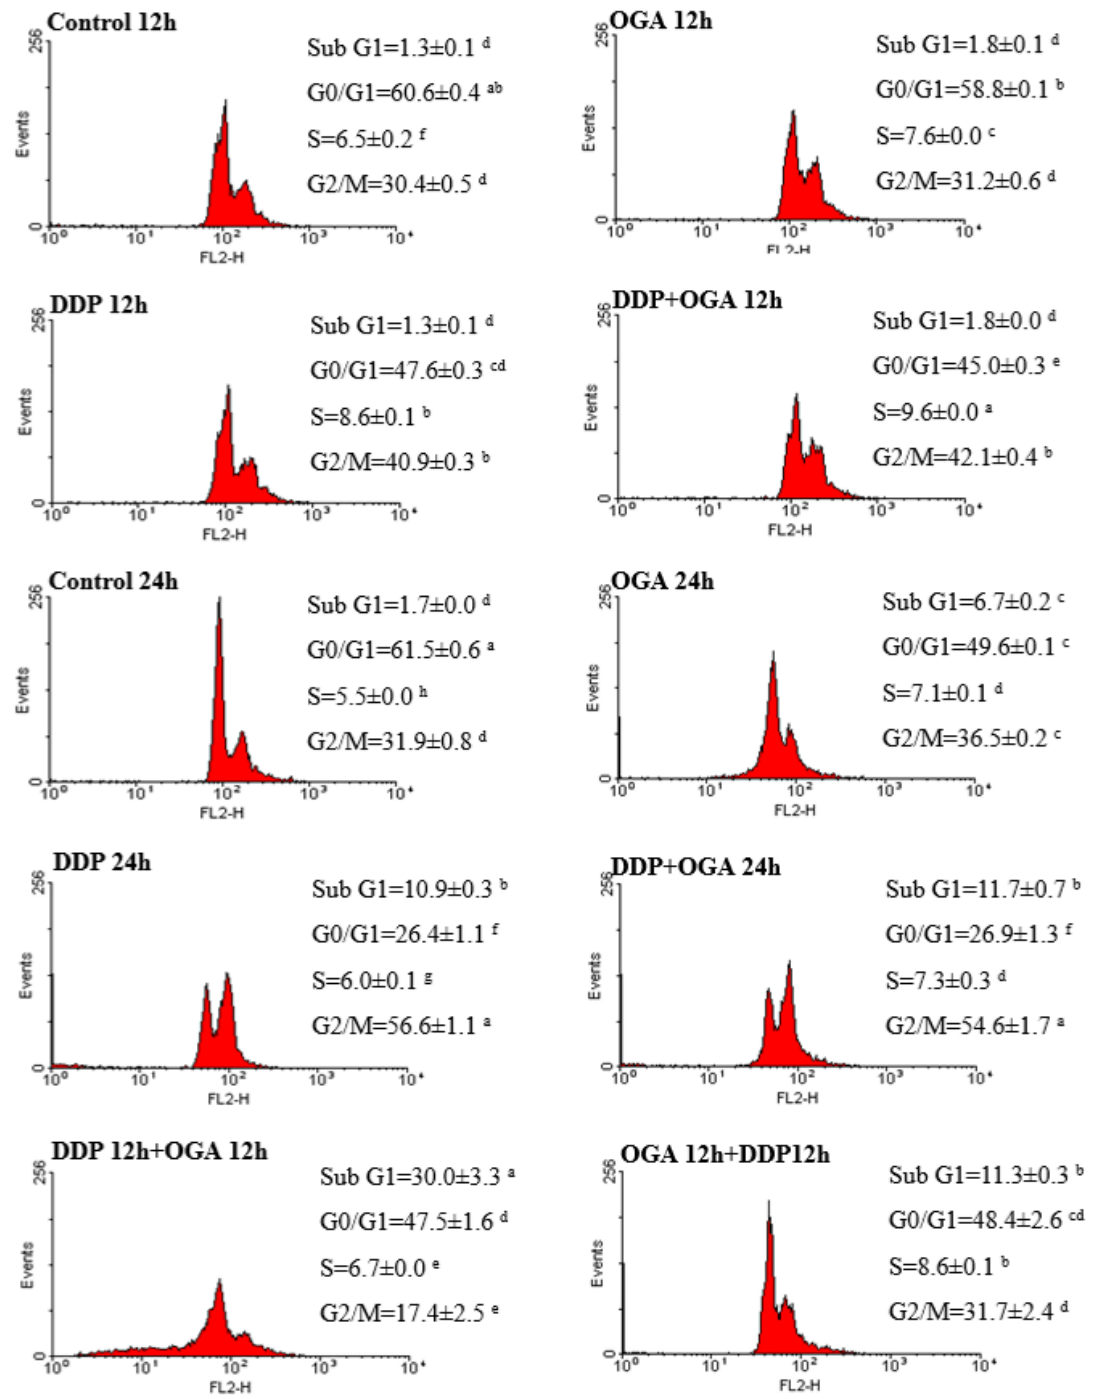
Figure 3. Flow cytometry analysis of cell cycle in A549 cells after DDP and OGA treatment. Cells were cultivated with OGA, DDP, DDP + OGA, DDP then OGA, and OGA then DDP at 37 °C for a total of 12 to 24 h. Values are expressed as means ± SD. Values bearing different letters are significantly different from one another in the same cell cycle population ( p > 0.05). Control 12 h: untreated and 12 h-incubated A549 cells, Control 24 h: untreated and 24 h-incubated A549 cells, DDP: cisplatin at 2 µ g/mL, OGA: oligogalacturonides at 100 µ